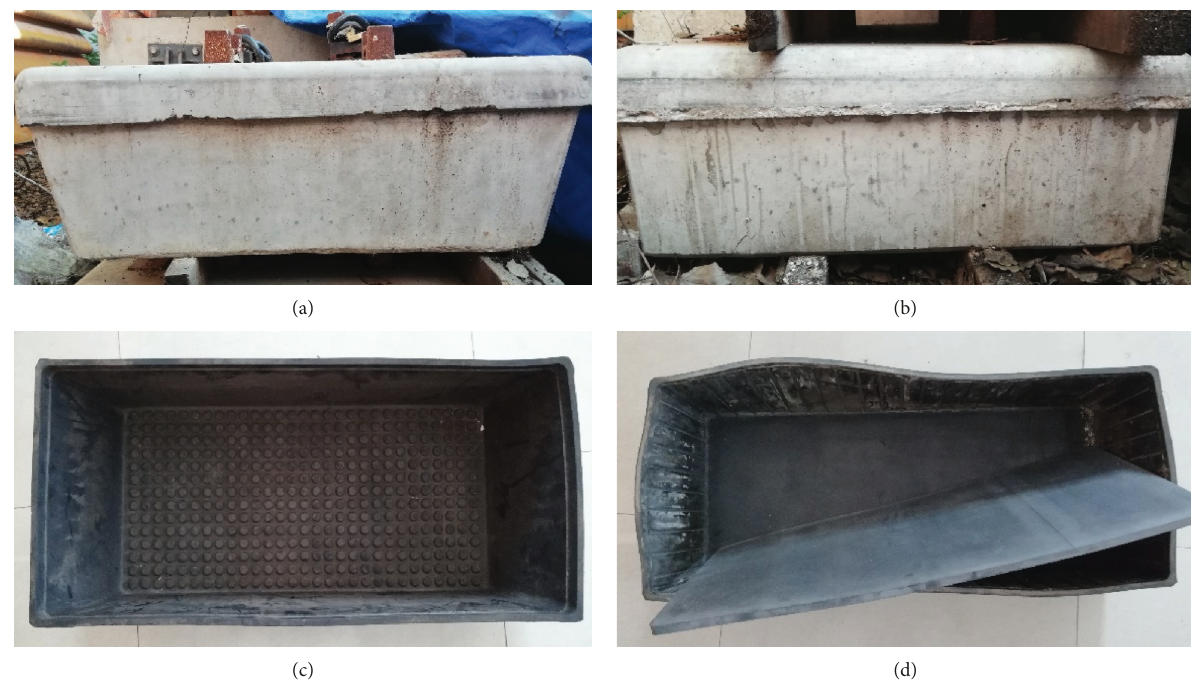
Figure 1: Images of bearing block and rubber boot. (a) N-LVT bearing block front view. (b) T-LVT bearing block front view. (c) N-LVT rubber boot top view. (d) T-LVT bearing block top view.